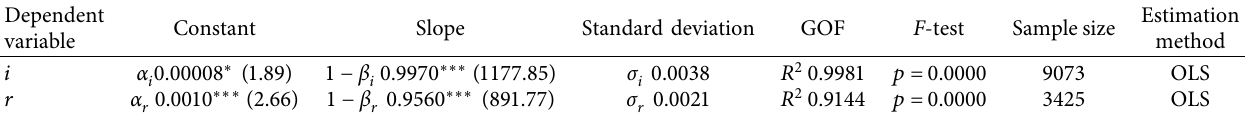
Table 2: Model parameter estimation results.